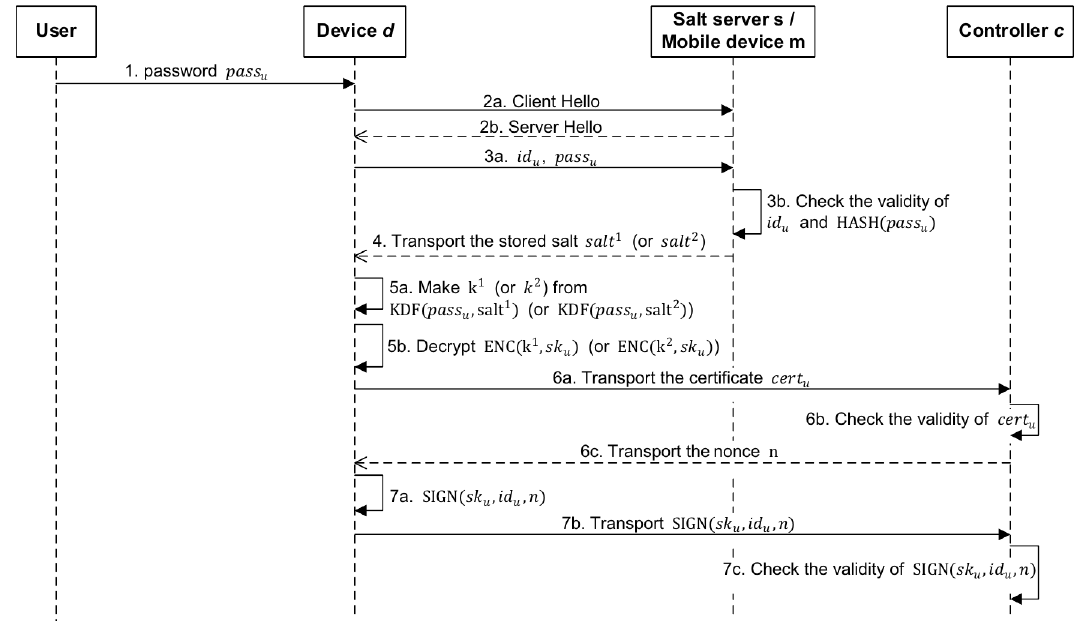
Figure 3. User authentication procedure using either the salt server (with salt 1 ) or the mobile device (with salt 2 ) in the proposed